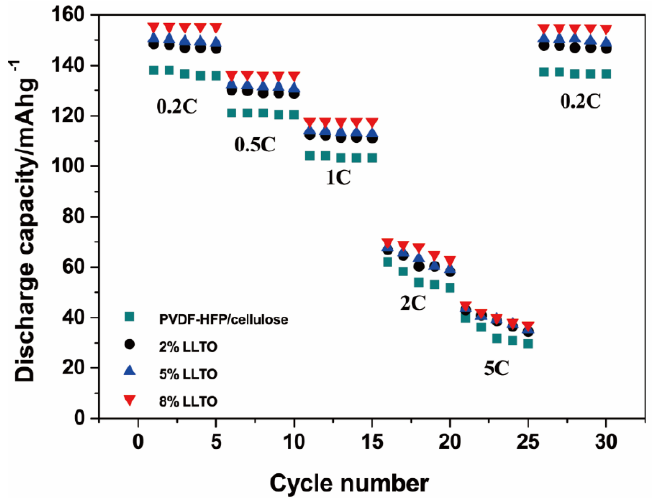
Figure 9. Rate performance of cells using PVDF ‐ HFP/cellulose and LLTO composite nanofibrous membrane.